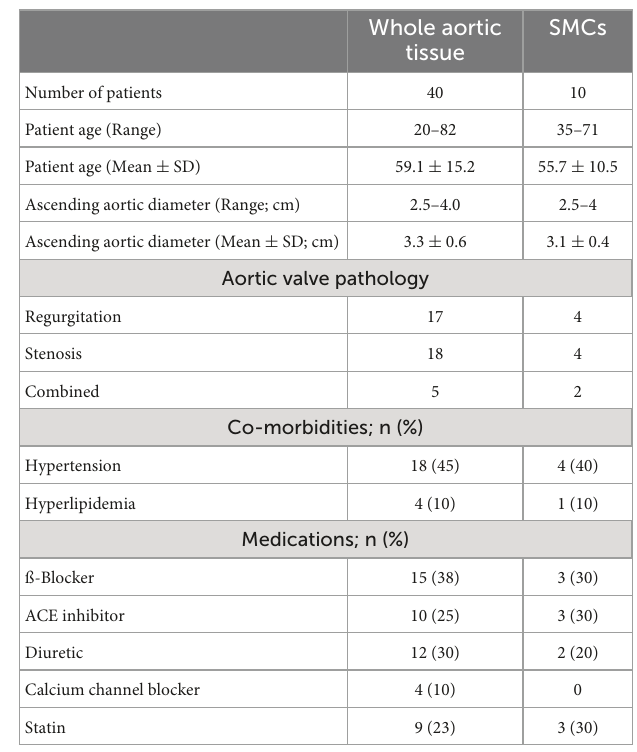
TABLE 1 Patient